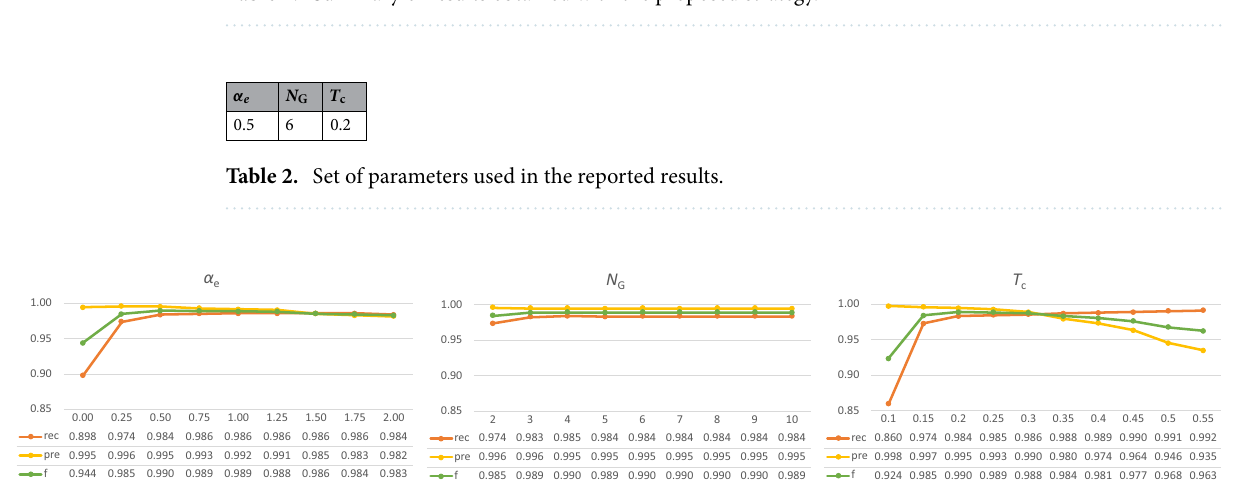
Figure 8. Quality of the results based on the values of the parameters on which the proposed strategy